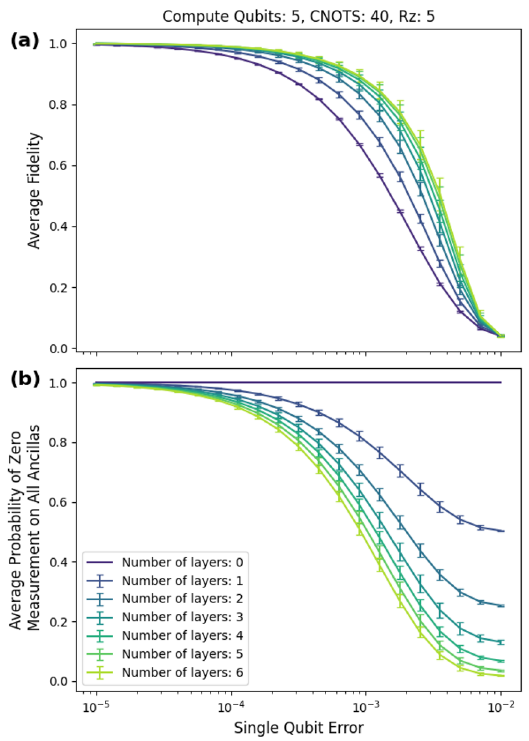
Figure 11. ( a ) Average fidelity for layers zero to six. At the peak fidelity gain, the nonmitigated circuit has about 33% fidelity, and the six-layer mitigated circuit has about 67% fidelity. ( b ) Probability of